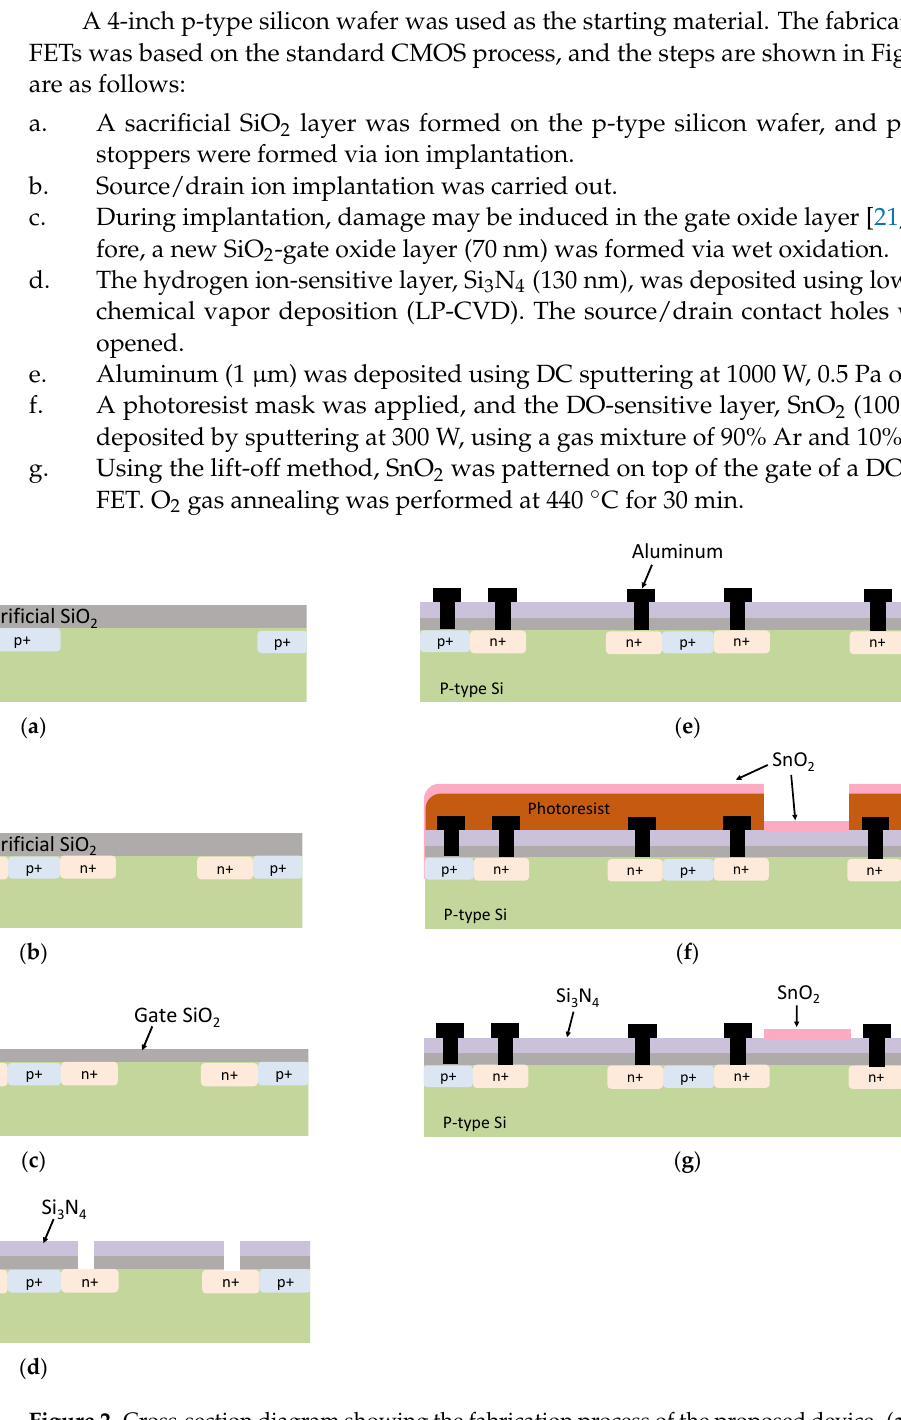
( b ) Figure 3. Optical microscope photo of the fabricated FET. ( a ) SnO 2 -gate FET; ( b ) Si 3 N 4 -gate FET. 2.4. Measurement Procedure An external silver/silver (I) chloride (Ag/AgCl) glass reference electrode was sus- pended above the FET to ensure that the bottom edge touched the solution surface (Figure 4). The source, drain, and reference electrodes were then connected to a semiconductor parameter analyzer (Agilent Technologies B1500A, Santa Clara, CA, USA) for the I–V